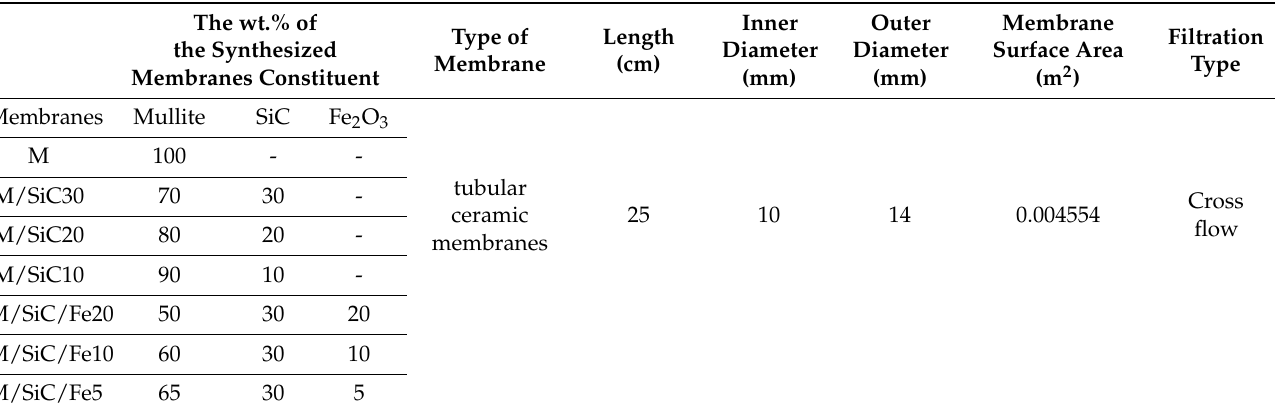
Table 3. Characteristics of fabricated ceramic